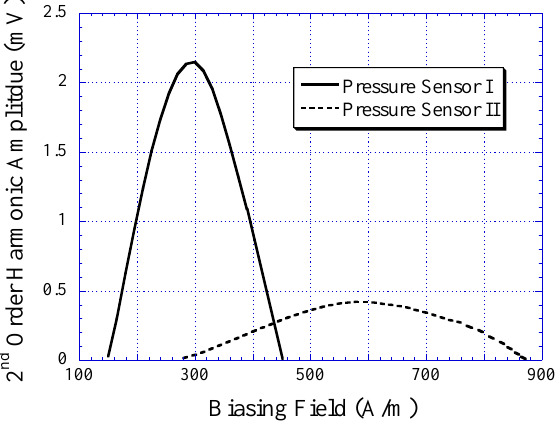
Figure 9. The 2nd-order harmonic fields produced by Sensors I and II. Note that the harmonic shift presented was due to the variation in separation distance between the magnetically-soft material and the permanent magnet, which was different for Sensors I and II.